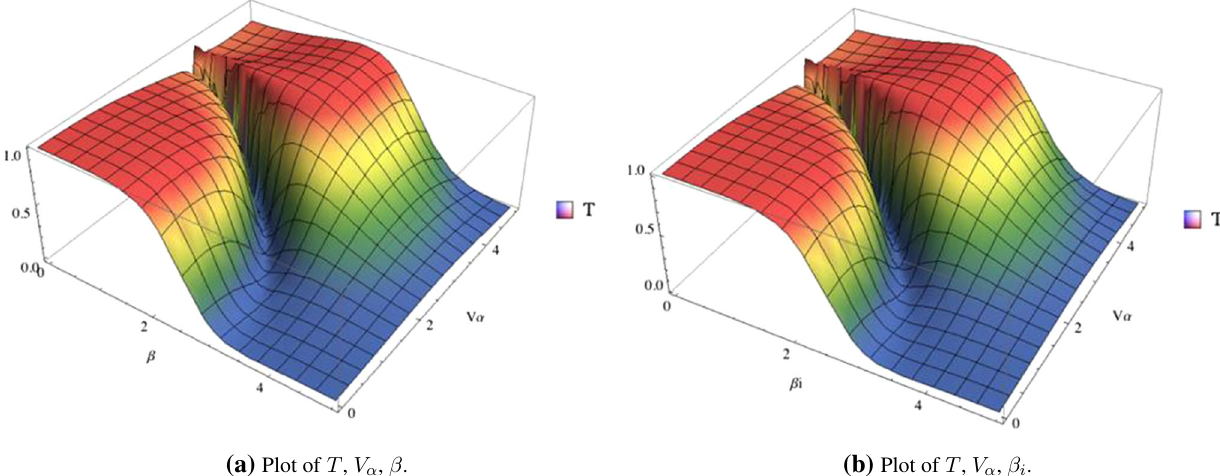
Fig. 3 Treatments of the transition coefficients versus the potential